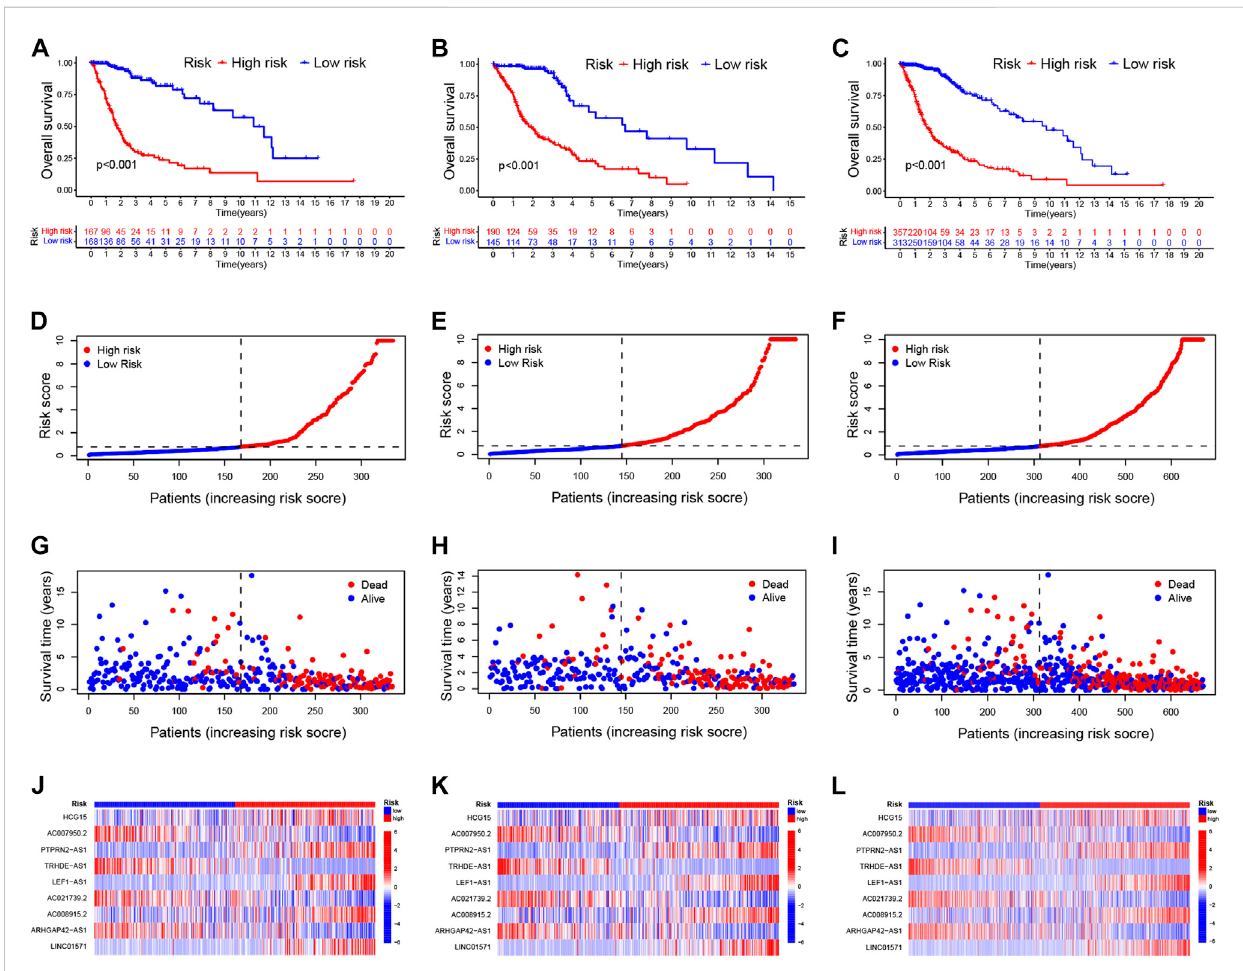
FIGURE 2 Validation of the prognostic signature of CRLs (A – C) . Kaplan – Meier curves for OS in the training sets (A) , testing sets (B) , and entire set (C) (D – F) . DistributionoftheCRL-model-basedriskscoreforthetrainingsets (D) ,testingsets (E) ,andentireset (F)(G – I) .Patternsofsurvivaltimeandsurvivalstatus ranked by risk score inthe training sets (G) , testing sets (H) , and entire set (I) (J – L) . Heatmap showing thedisplay levels of thetenlncRNA for each patient in the training sets (J) , testing sets (K) , and entire set (L) . CRL, cuproptosis related lncRNA; OS, overall